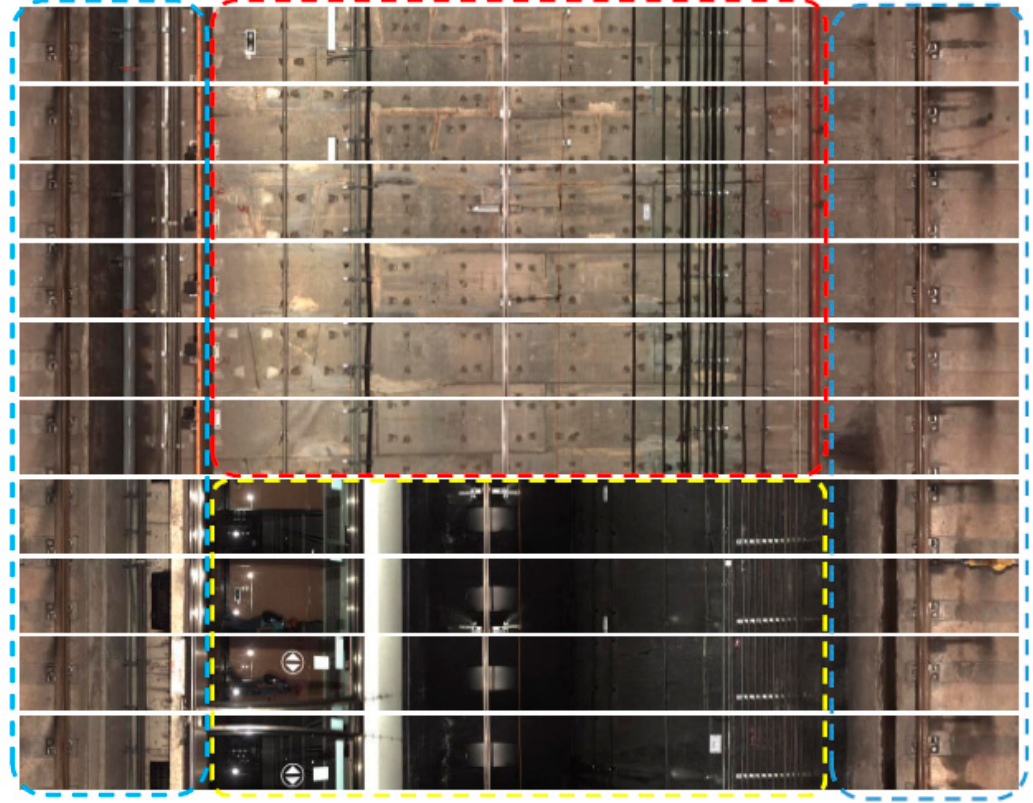
Figure 1. The stitched images of tunnel sections.